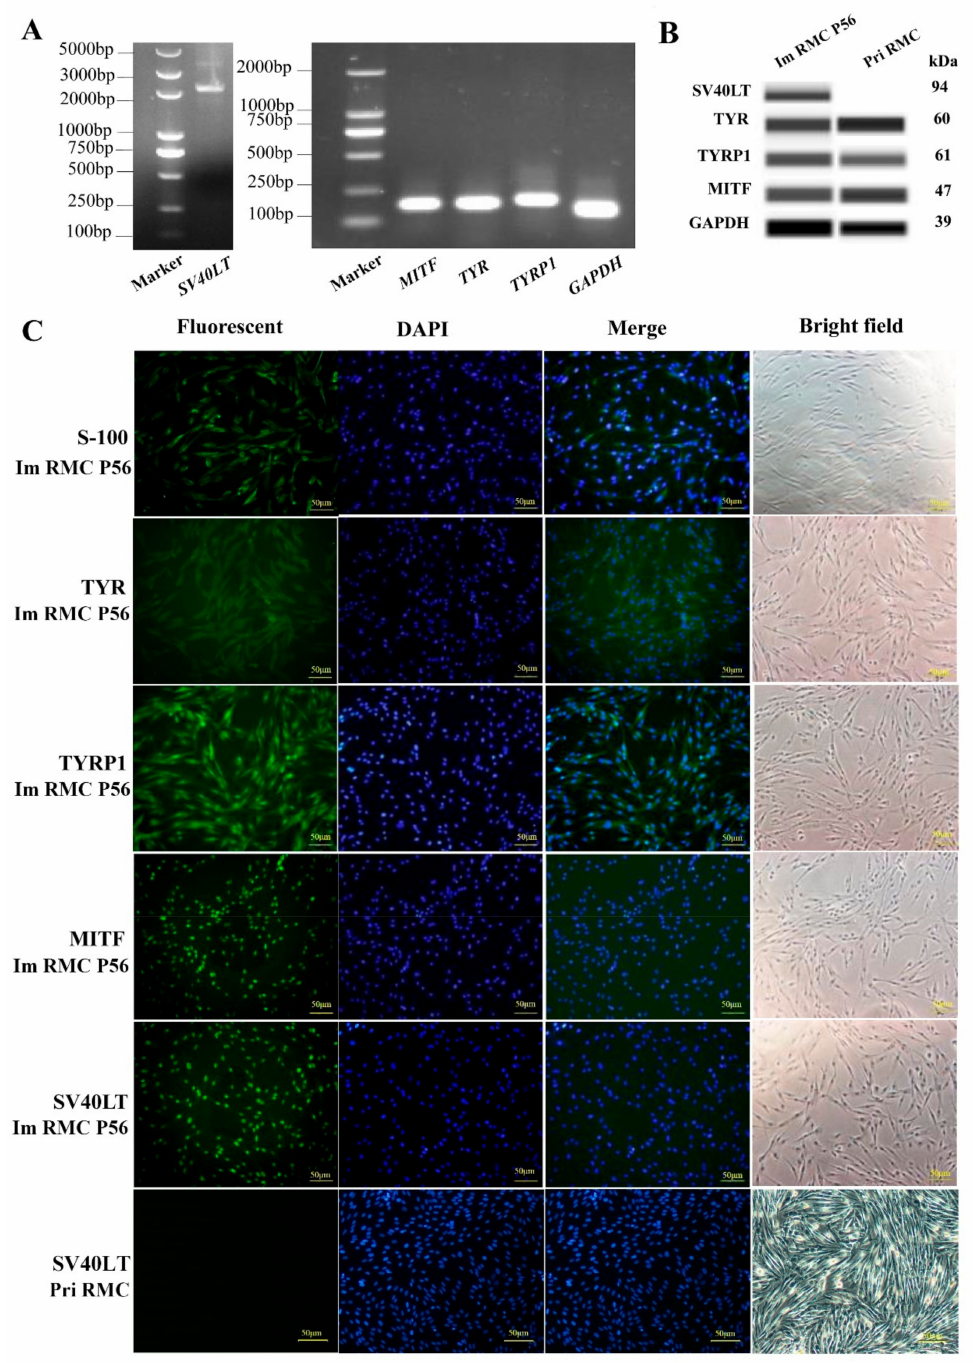
Figure 3. Tissue-specific gene expression in primary and immortalized melanocytes. ( A ) Expression of SV40-LT , MITF , TYR , TYRP1, and GAPDH in Im RMCs by SqPCR. ( B ) Western blot analysis and ( C ) immunofluorescence (200 × ) in Pri RMCs and Im